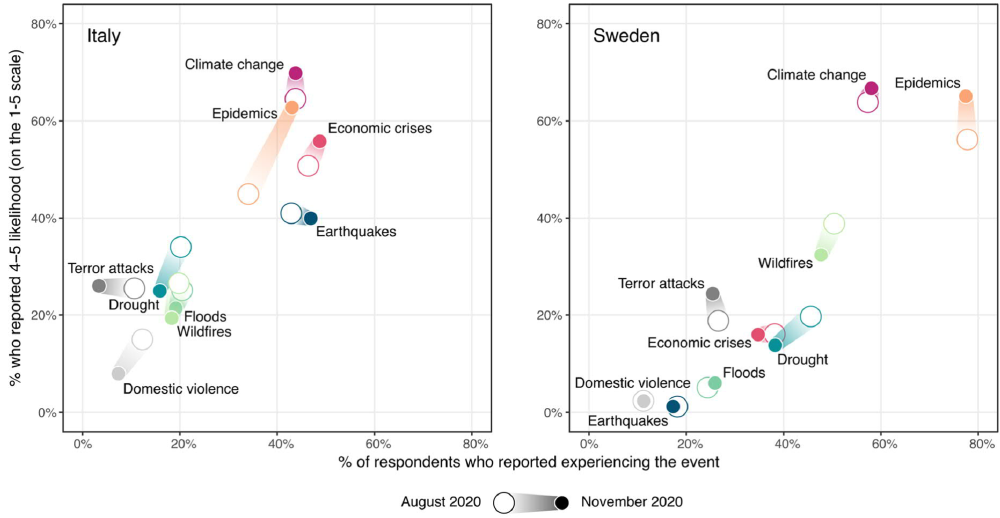
Figure 4. Experience and perceived likelihood. The proportion (%) of people who have experienced each threat versus the proportion (%) of people who perceived it as